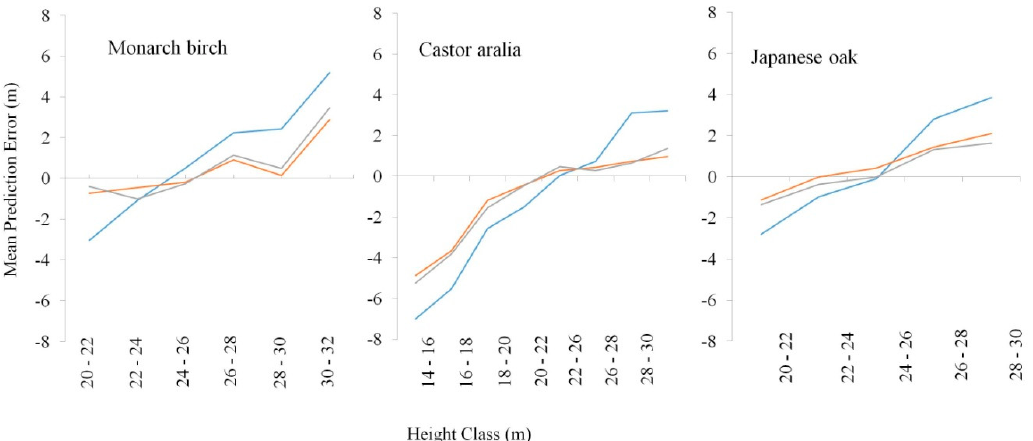
Figure 7. Mean prediction errors and height classes (field measured height). Blue, red, and gray lines represent mean prediction errors for field height, LiDAR height, and UAV-DAP height, respectively.